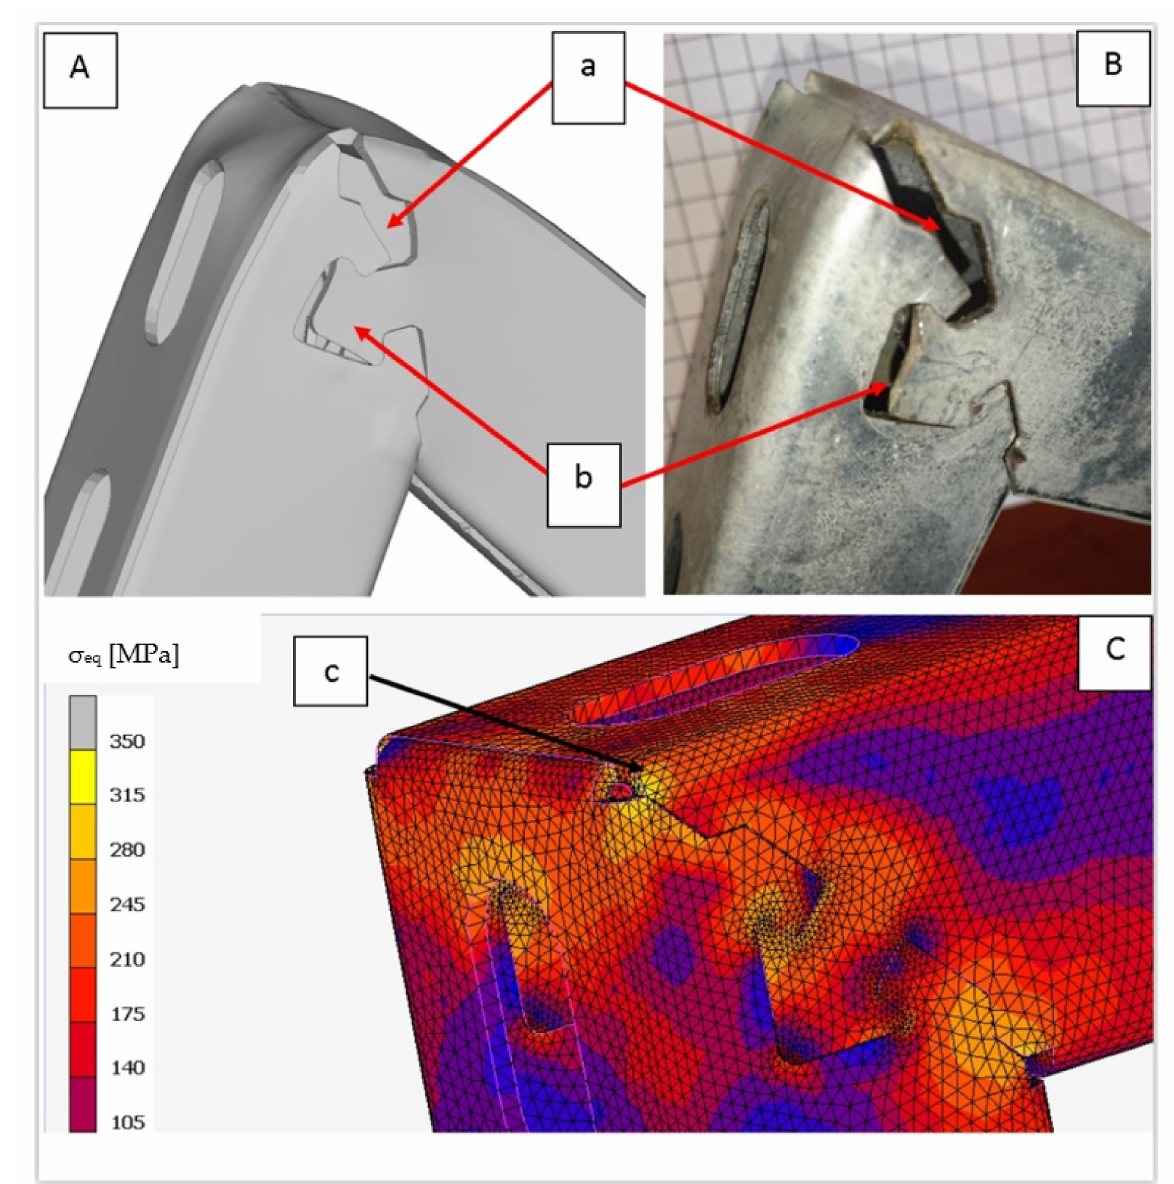
Figure 21. The degradation of the console top edge: results of numerical simulation ( A ) and stand tests ( B ); stress distribution at stage at which degradation start; degradation zone—a, lock deformation—b; initial degradation zone—c ( C